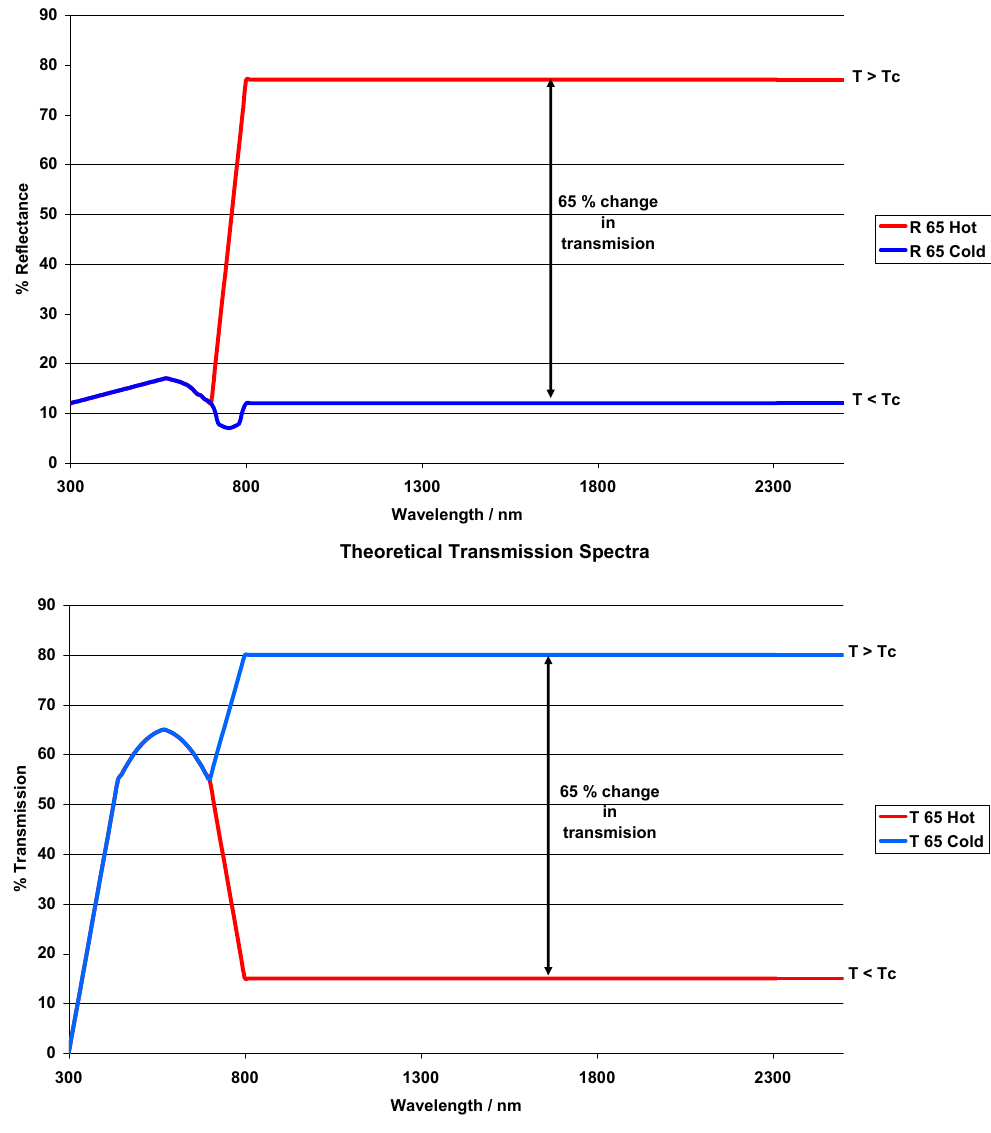
Figure 9. Idealized ‐ theoretical transmission/reflectance data. Figure 9. Idealized-theoretical transmission/reflectance